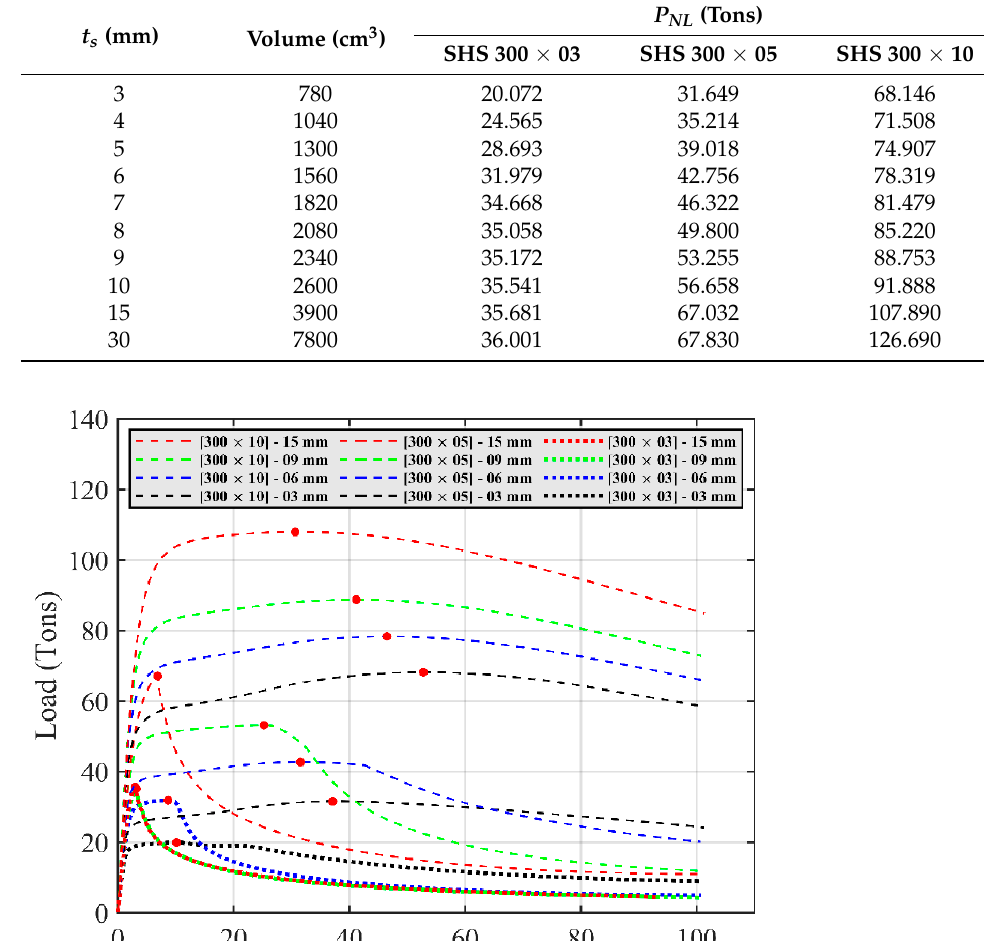
Figure 10. Optimal stiffener topology for SHS-300 × 0.5 columns with various volume fractions. The maximum crane loads 𝑃 (cid:3015)(cid:3013) , such that the SHS columns in an IBBC area could sufficiently carry the loads after retrofitting using the optimal-topology design of the ex- ternal stiffeners, are summarized in Table 3. The total design volumes associated with the controlled volume fractions are also reported. It was evident that for a similar targeted maximum crane load 𝑃 (cid:3015)(cid:3013) , the total required volume of the optimal-topology stiffeners was less than that of the standard uniform U-shaped plates for SHS columns. For instance, for the SHS-300 × 05 column to sufficiently support 𝑃 (cid:3015)(cid:3013) ≥ 48 tons, the BESO approach was used to design the optimal layout of stiffeners shown in Figure 9e, with 𝑉 ∗ = 0.1 , for which the total volume of 773 cm 3 (viz., yielding 𝑃 (cid:3015)(cid:3013) = 48.611 tons ) was significantly less than that of the uniform U-shaped plates (namely, 2080 cm 3 for 𝑃 (cid:3015)(cid:3013) = 49.800 tons ). The nonlinear load and displacement responses of the I-section corbel associated with the SHS column in an IBBC area are mapped out in Figure 11 for various optimal- topology designs. It was clear that the optimal-topology stiffeners with higher volume fractions provided greater maximum crane load capacities to the columns. The strength enhancement was apparent in non-slender compression columns (e.g., SHS-300 × 10). The advantages of optimal retrofitting were not as evident when the slender columns (SHS-